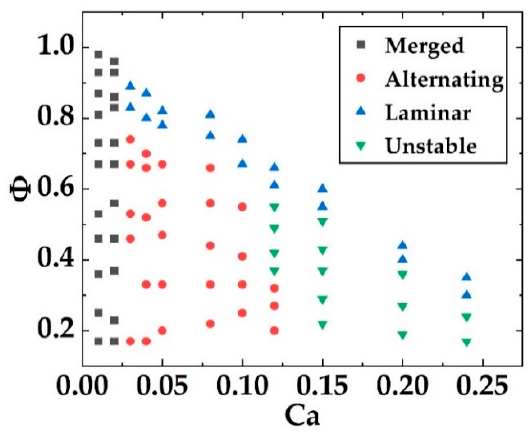
Figure 6. Plot of capillary number, Ca, versus flow rate fraction, Φ .